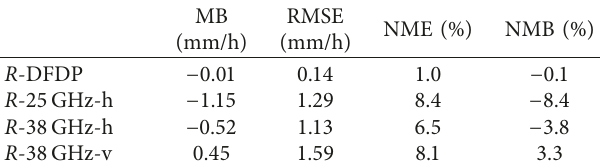
Table 7: Statistical parameters of the first group for R .